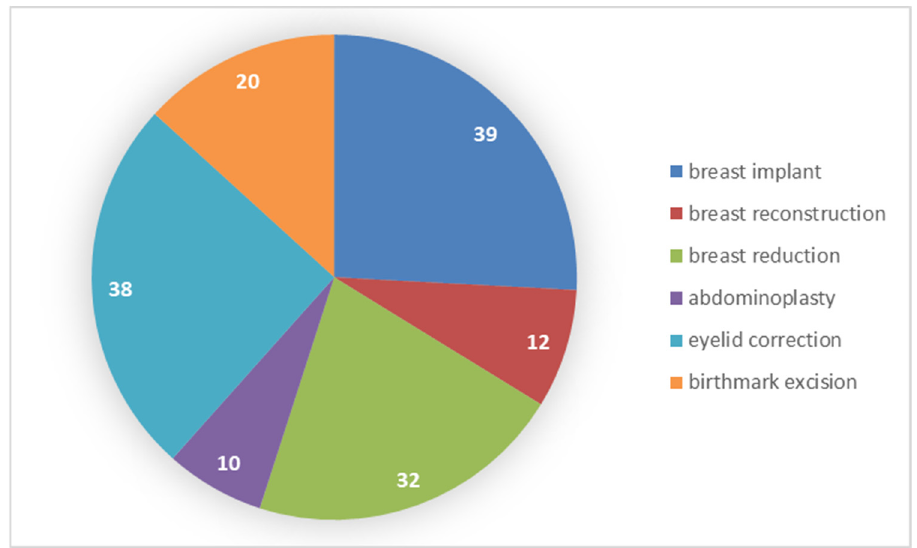
Figure 1. Number of patients in relation to the chosen type of surgery.